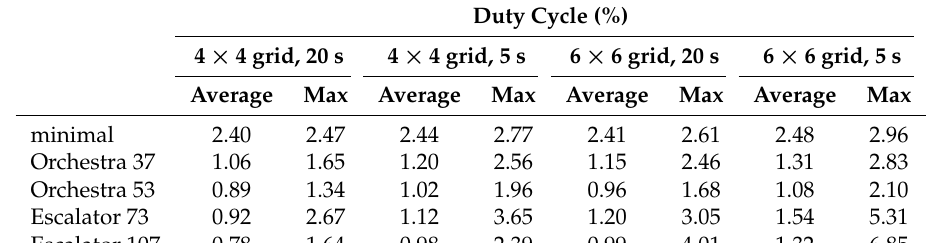
Table 2. Measured average and max duty cycle in the simulations.